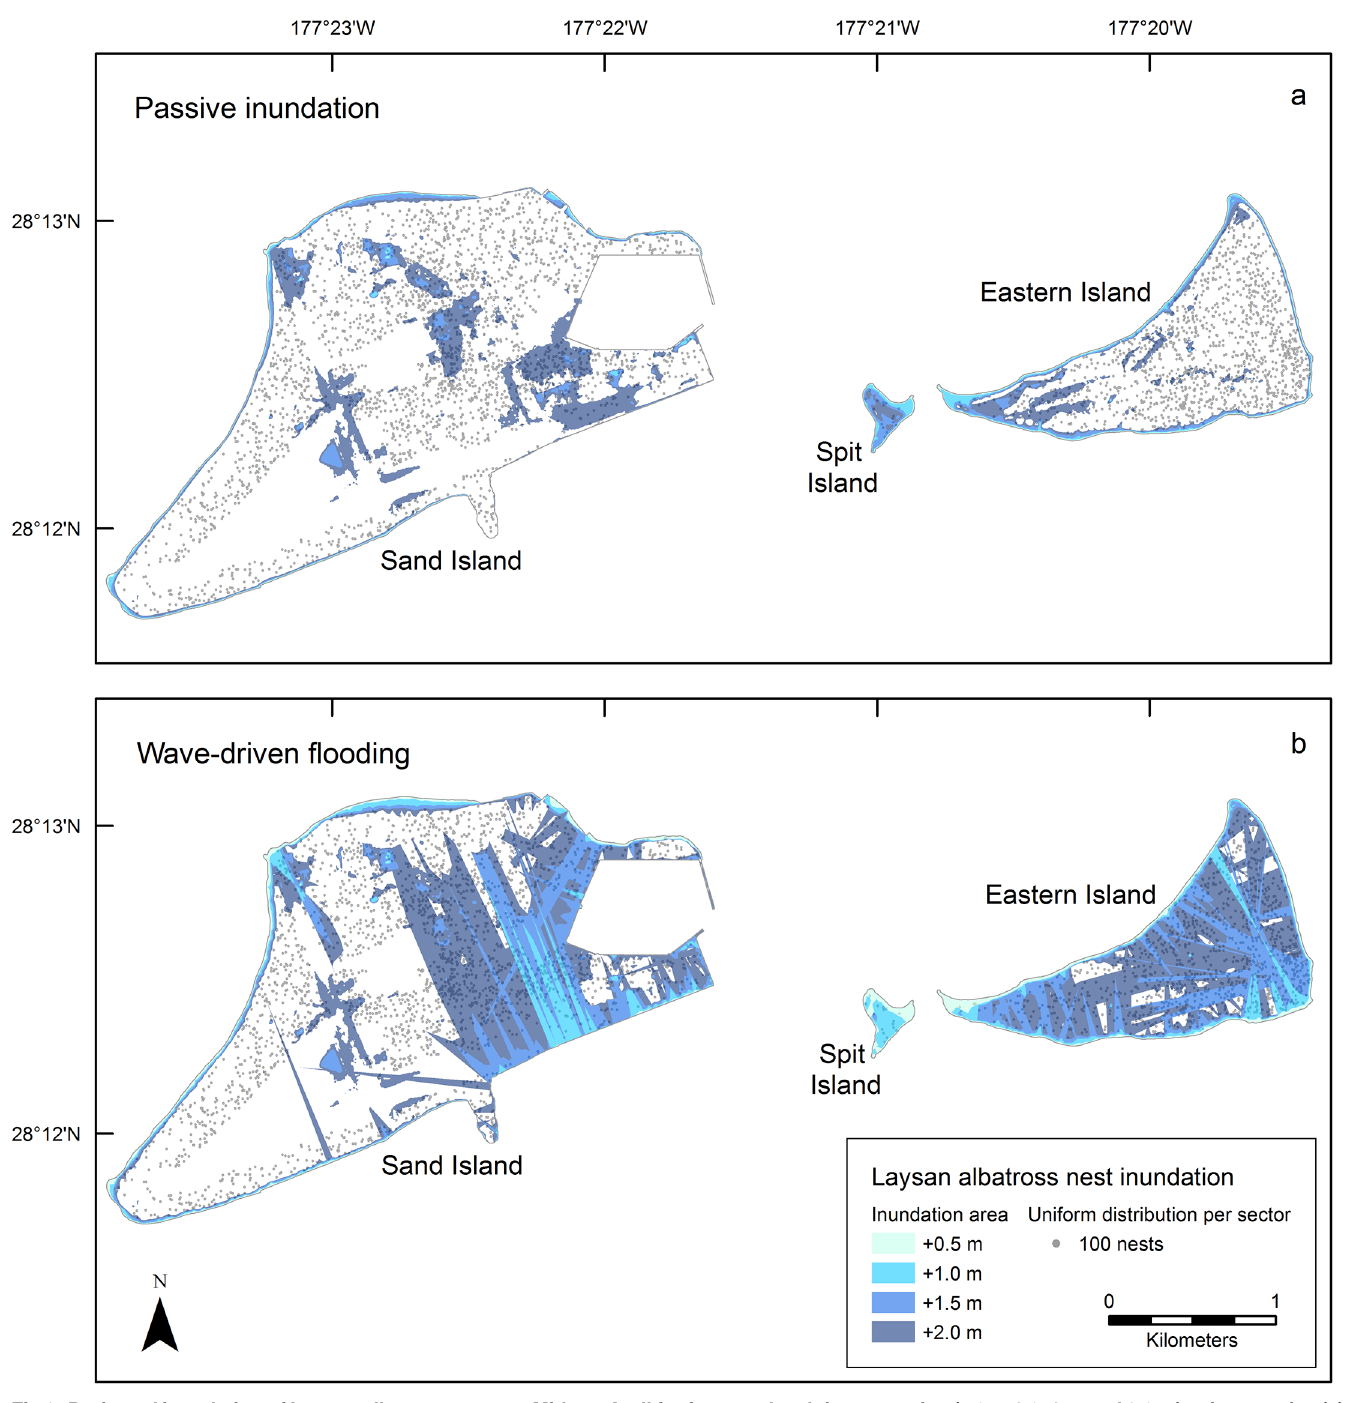
Fig 3. Projected inundation of Laysan albatross nests at Midway Atoll for four sea-level rise scenarios (+ 0.5, 1.0, 1.5, and 2.0 m) using passive (a) and wave-driven (b) models, including groundwater rise. 48% of the nests on Sand and 90% of nests on Eastern flooded (Table 4). At +1.5 and +2.0 m of SLR, wave-driven water flooded most of Eastern Island, and all of Spit Island (Fig 3).